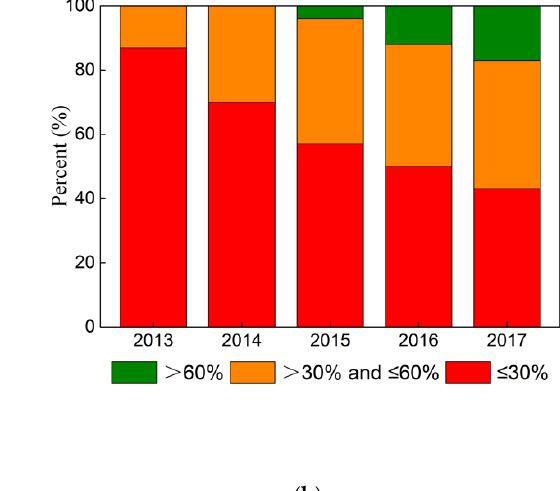
Figure 9. Trends in ( a ) NO X emission from major industrial processes; ( b ) denitration efficiency for cement industry.